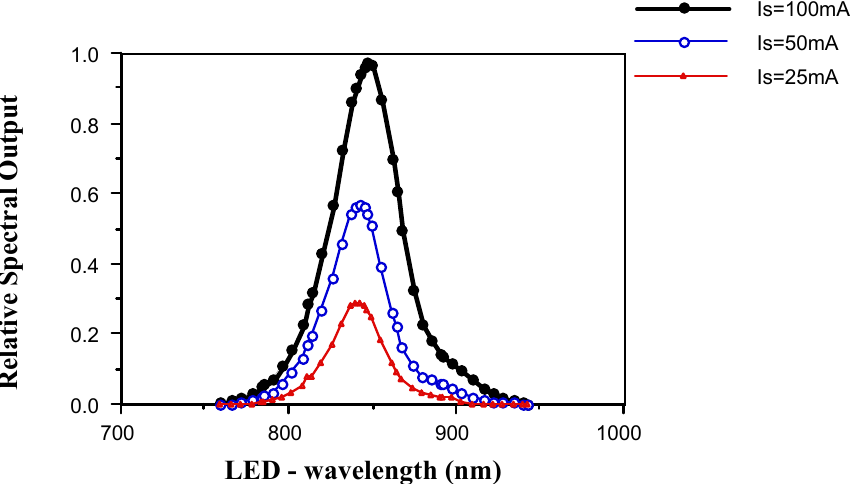
Figure 4. Relative spectral output vs. wavelength of the tested diode measured with a monochromator. There are three close Gaussian shapes at the forward currents: I s = 25, 50, and 100 mA [30]. According to the data sheet in [54] and the measurand, ∆ λ is approximately 60 nm. Thus, the coherence length ( L c ) in this light source, as determined by Equation (9), is approximately 8 µ